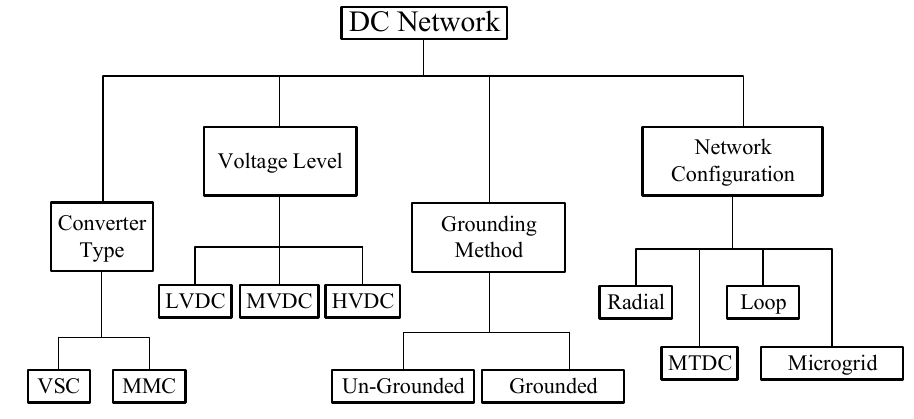
Figure 2. DC network